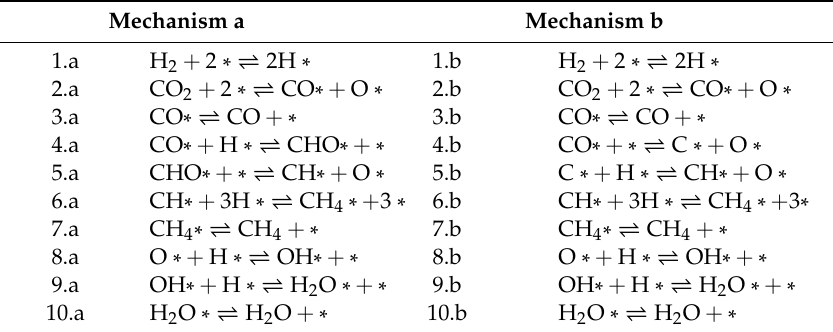
Table 11. Reaction mechanism proposed in the